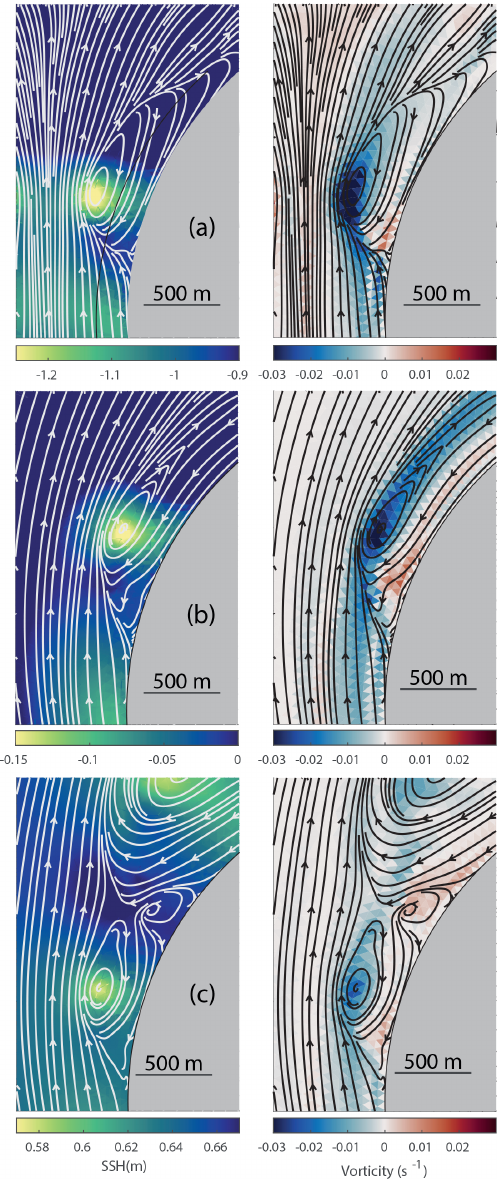
Figure 9. Sea surface height (left) and vorticity (right), with con- tours showing the corresponding streamlines, are shown at sepa- ration time. We show the fields in the three straits displayed in (a) Fig. 5 ( W = 1km), (b) Fig.6 ( W = 4 . 5km), and (c) Fig. 7 ( W =